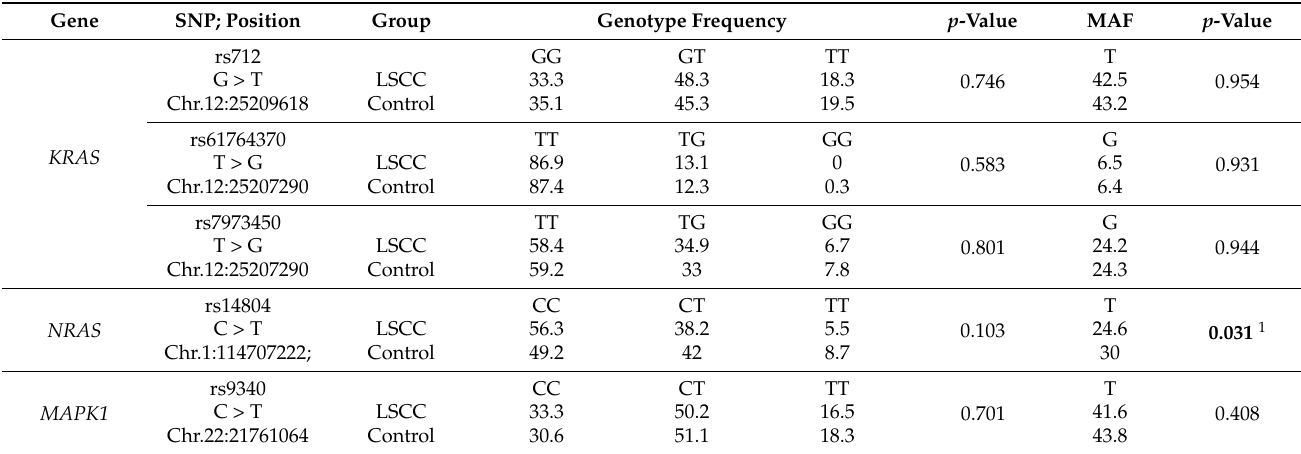
Table 4. Distribution of genotypes and alleles frequencies for polymorphisms at KRAS , NRAS , MAPK1 genes in LSCC ( n = 327) and control ( n = 333)